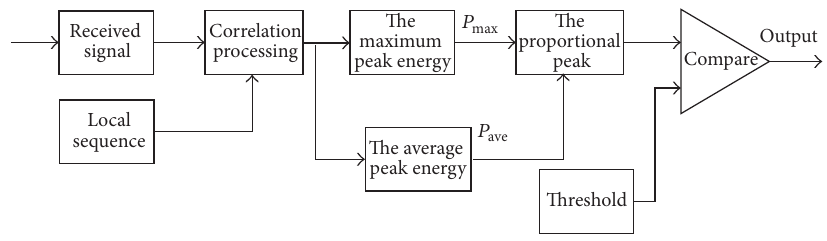
Figure 5: The proportional decision